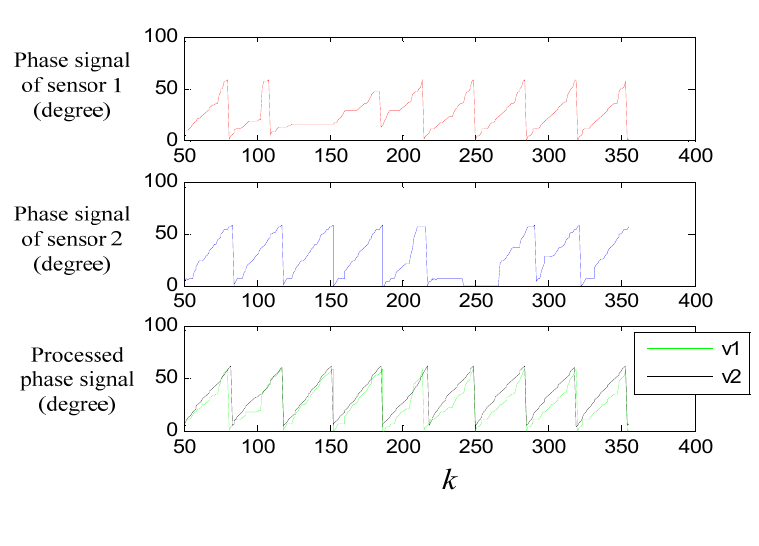
Figure 23. Switching experiment